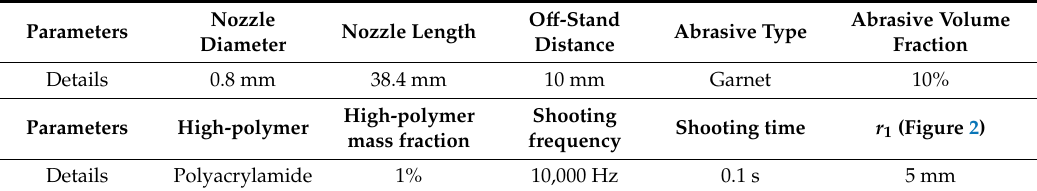
Table 2. Details of the parameters.